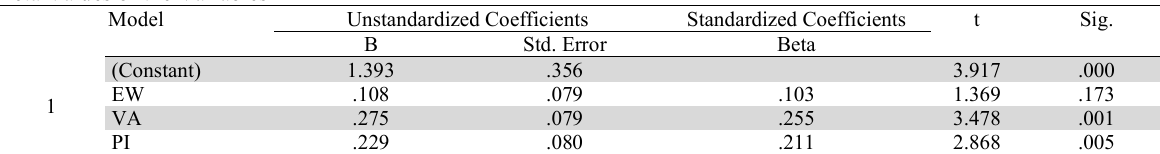
Table 8 verified that independent variables explain (17.4%) of the dependent variable variance. The correlation coefficient after the entry of the brand image is (0.418) while it was (0.368) before brand image usage. This means that the brand image increased the correlation positiveness between the variables and also the regression is significant because the value of the statistical significance is (zero) which is less than (5%). To illustrate the type of relationship and which one of the variables has a greater effect on the dependent variable after the entry of the brand image, Table 9 presents the variables and beta values of it. Beta Values of the Variables